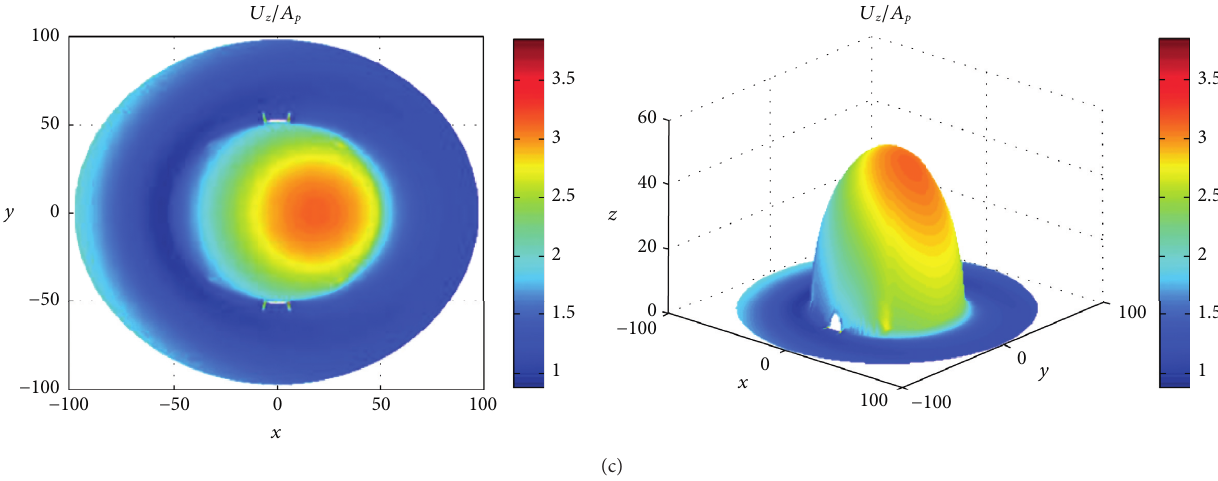
Figure 7: Surface displacement amplitude of the 3D tunnel mountain under the incident P wave ( η � 0 . 5 , α � 30 ° ): (a) surface displacement amplitude in x direction; (b) surface displacement amplitude in y direction; (c) surface displacement amplitude in z